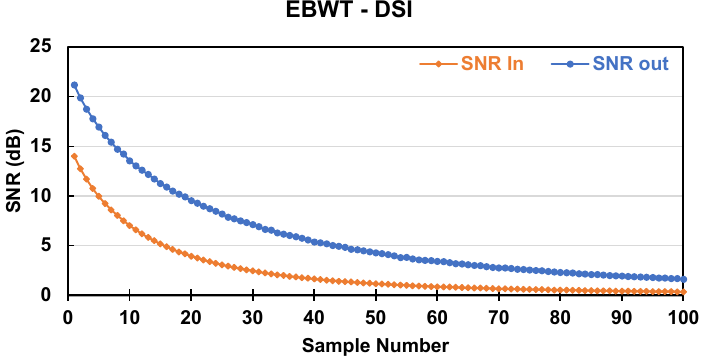
Figure 15. Output SNR using EBWT on 100 samples of DSI contaminated PD signals. Maximum ∆ SNR = 7.17 dB, Minimum ∆ SNR = 1.25 dB, and average ∆ SNR = 3.56